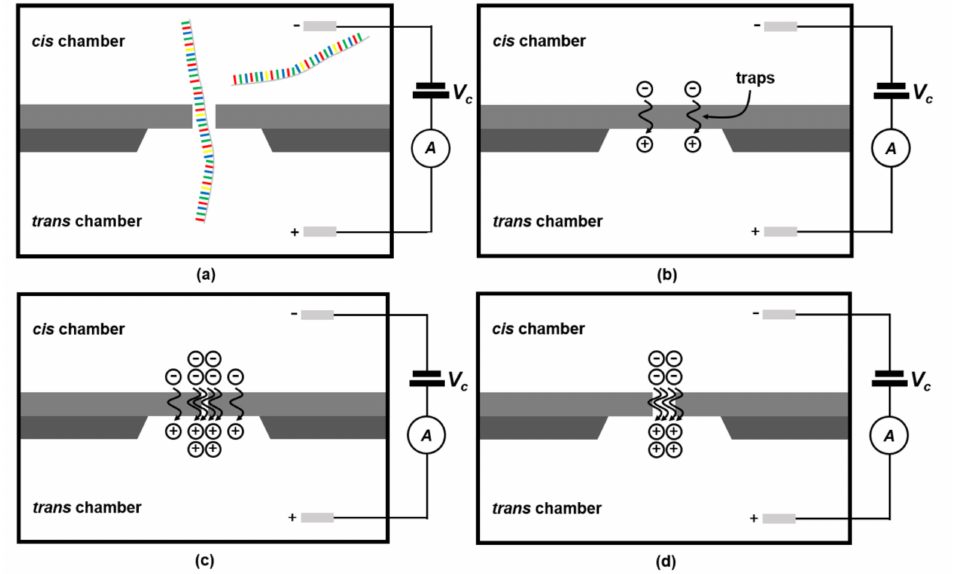
Figure 1. Nanopore formation using the controlled dielectric breakdown (CDB) technique. ( a ) Nanopore principle for DNA analysis; ( b ) leakage ionic current induced by an electric field resulting in a redox reaction and ionization; ( c ) dielectric breakdown occurring in an area with densely accumulated trapped electrons; ( d ) nanopore channel formation after